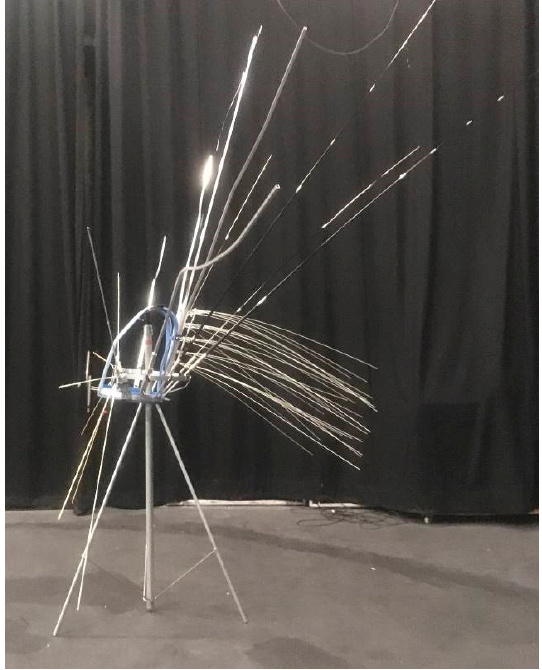
Figure 5. Completed frame to be worn over the unitard. The frame is shown supported on a stand.